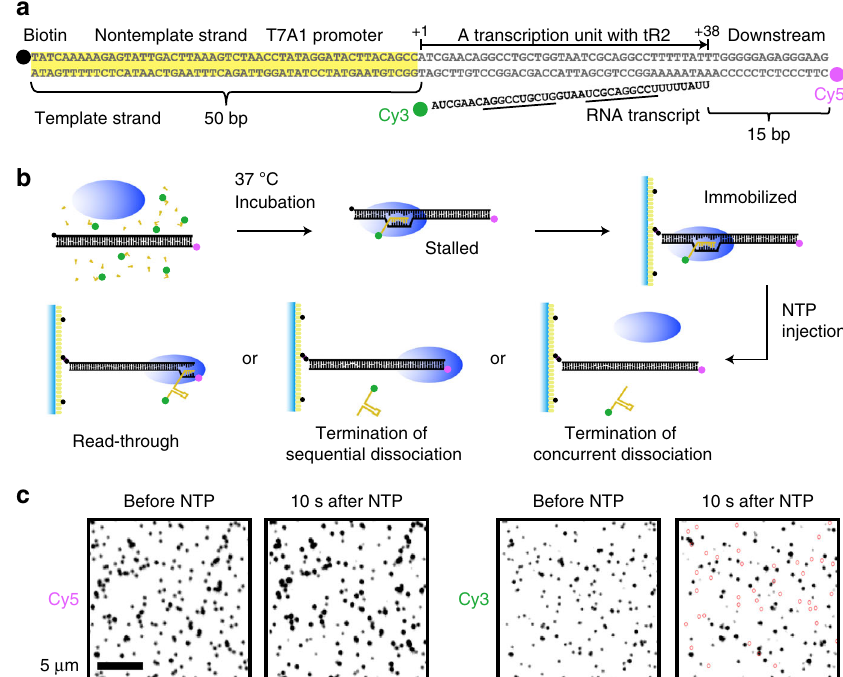
Fig. 1 Intrinsic termination observed in single-molecule fl uorescence experiments. a DNA template L + 15 with T7A1 promoter and tR2 terminator was prelabeled with biotin (black dot) at the upstream end and with Cy5 (magenta dot) at the downstream end. RNA transcript was labeled with Cy3 (green dot) at the 5 ′ -end. b Experimental scheme. Transcription complexes were stalled, immobilized, washed, and then resumed to follow readthrough or termination pathway. c Cy3-RNA and Cy5-DNA images (black spots) before and 10 s after NTP addition. Purple circles spot the termination complexes that have lost Cy3-RNA.